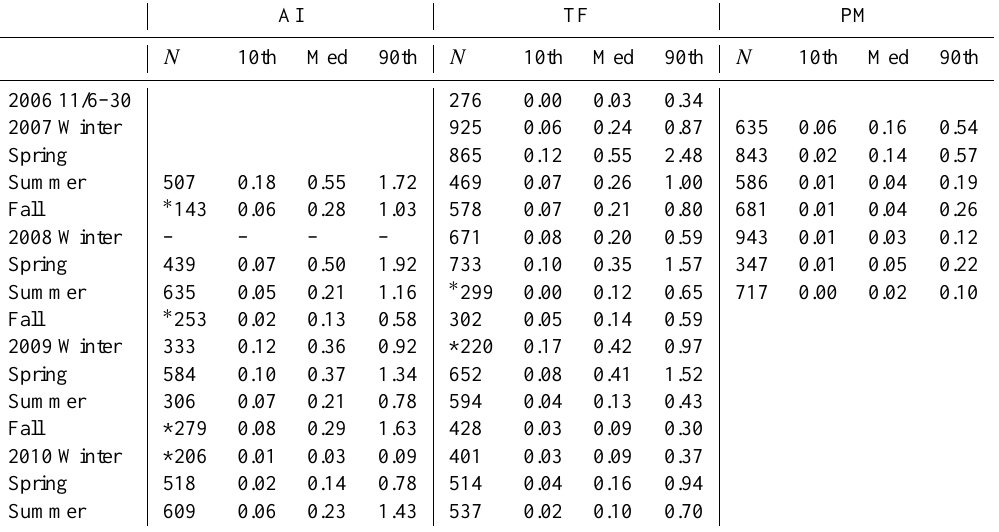
Table 2. The lower 10th, median and 90th percentile values of RGM (ppqv) at AI, TF, and PM. N stands for the total number of samples. The asterisked sample numbers stand for seasons with measurements missing consecutively for half of the season. AI TF